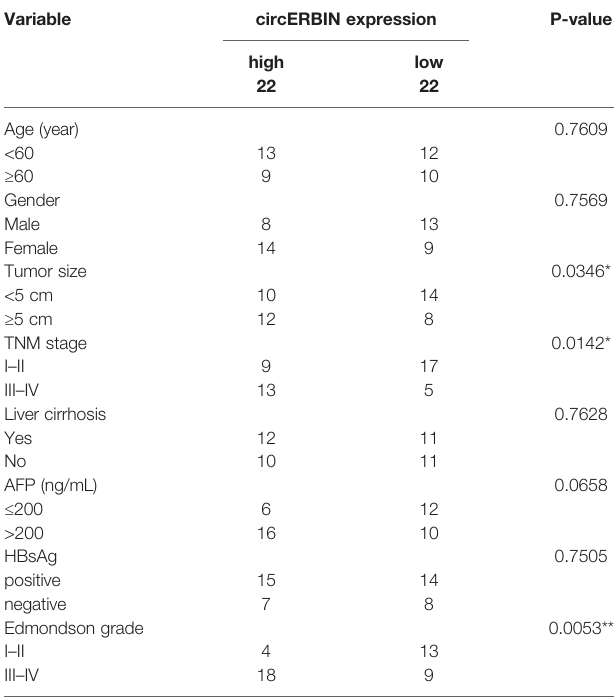
TABLE 1 | Correlation between circERBIN expression and clinicopathological features in HCC tissues (n = 44, c 2 -test).